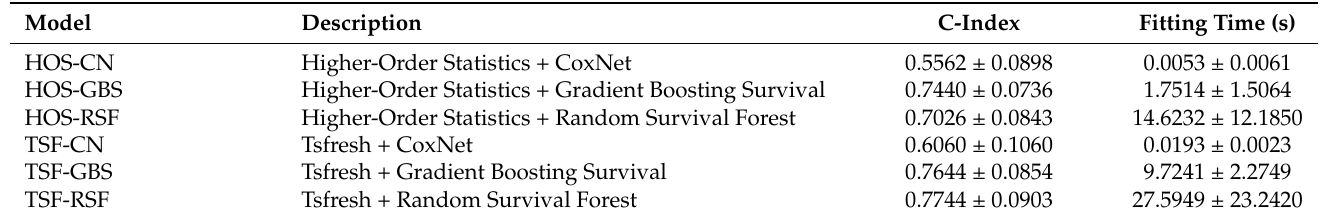
Table 2. C-index score and average computational time. TSF-RSF obtained the best average score, while HOS-CN achieved the lowest score at a reasonably lower fitting time.